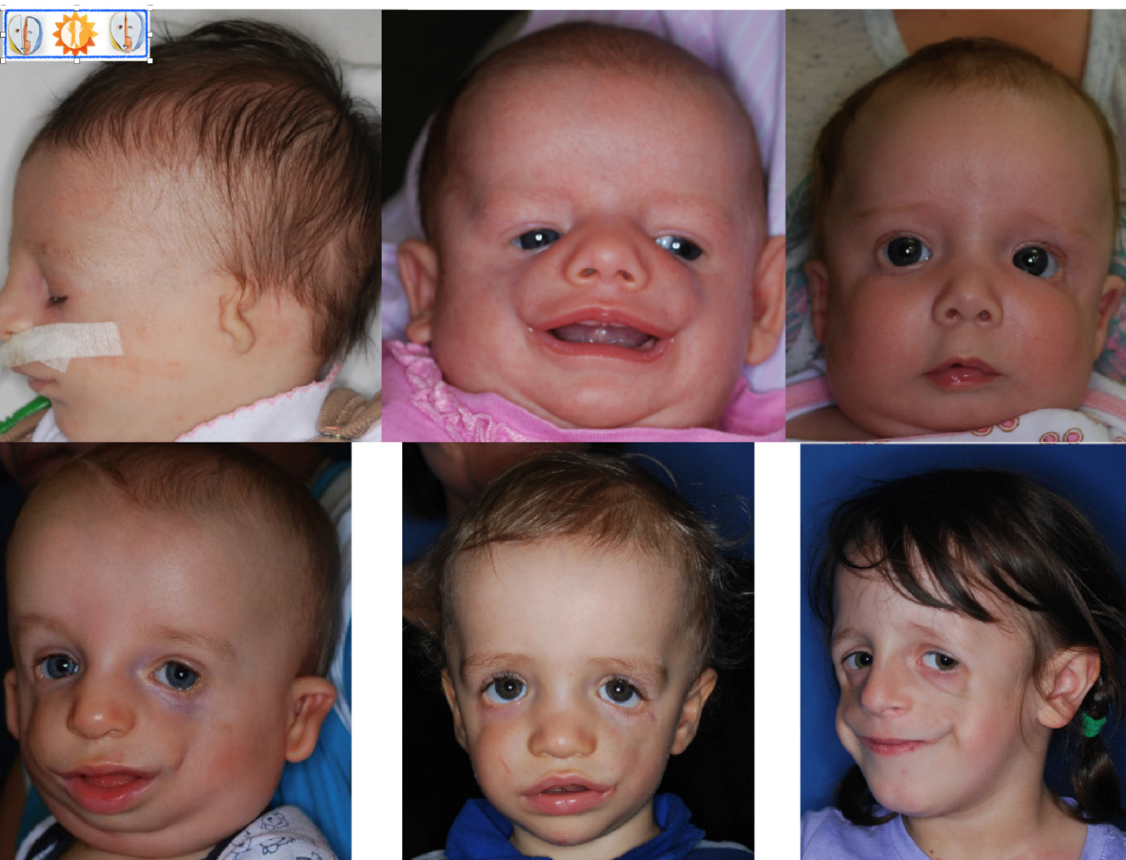
Figure 2. Patients with TCS at different ages, visible variations in defect severity.